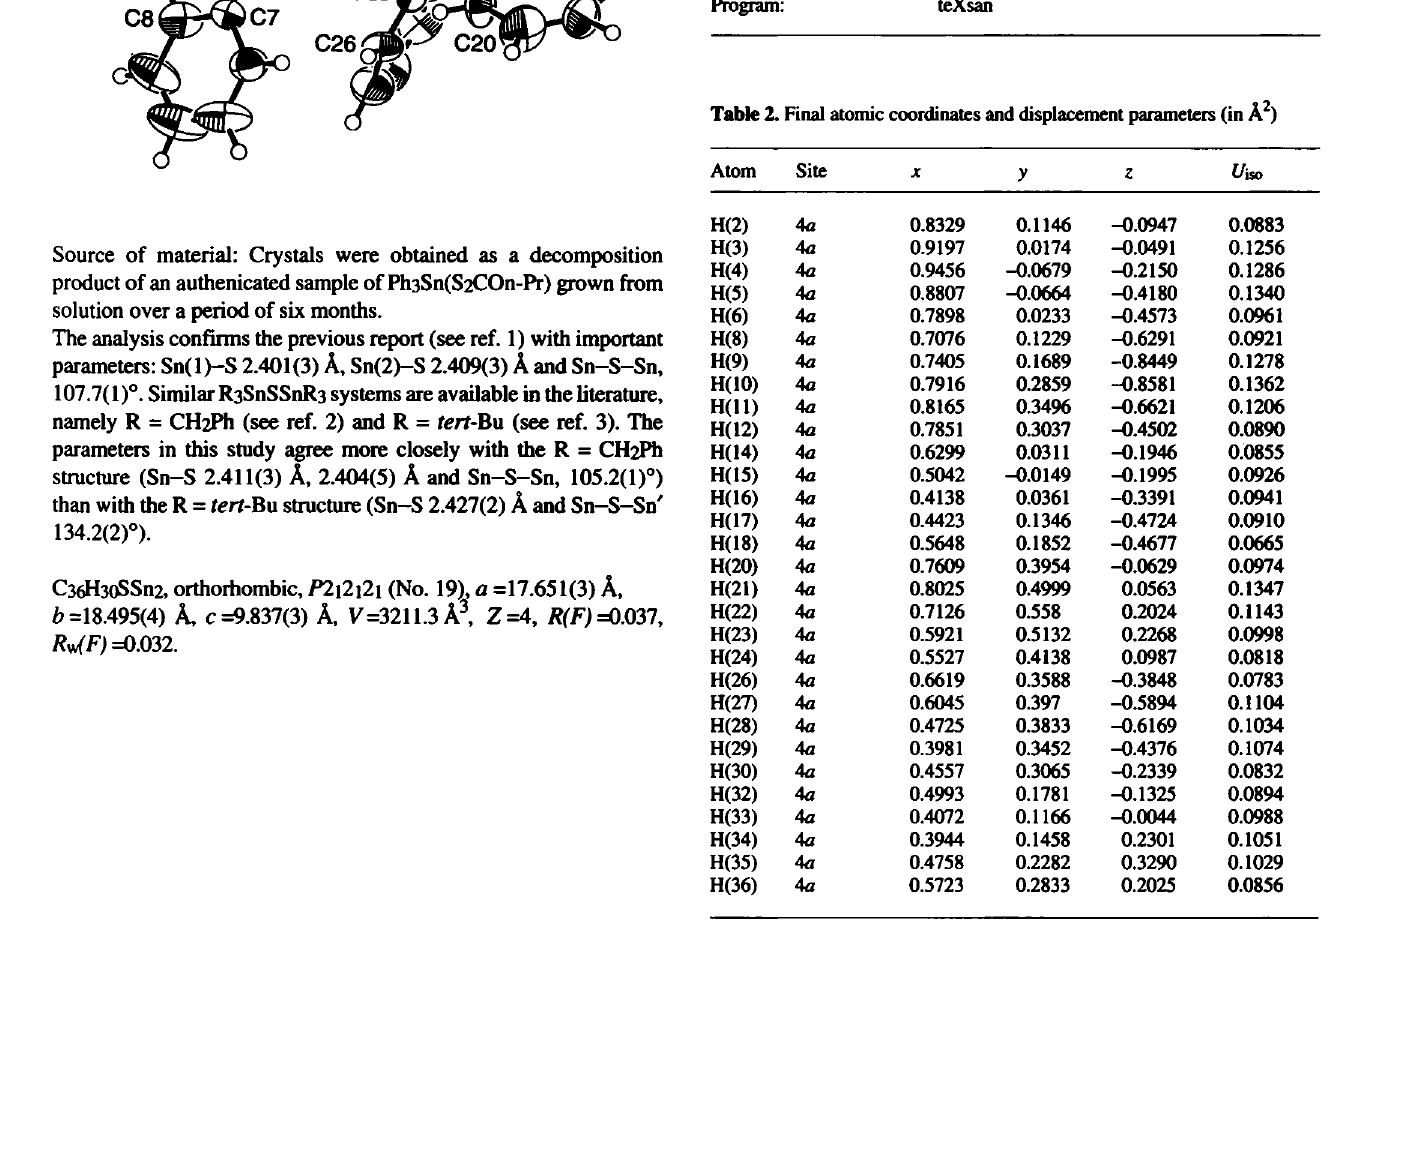
Table 2. Final atomic coordinates and displacement parameters (in Â 2 ) Atom